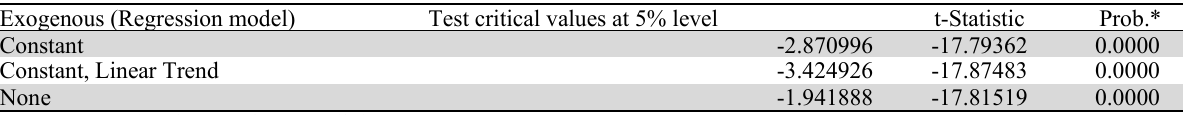
Exhibit the Output of Augmented Dickey-Fuller Test Statistic at Exogenous Constant, Constant with Linear Trend and None Exogenous (Regression